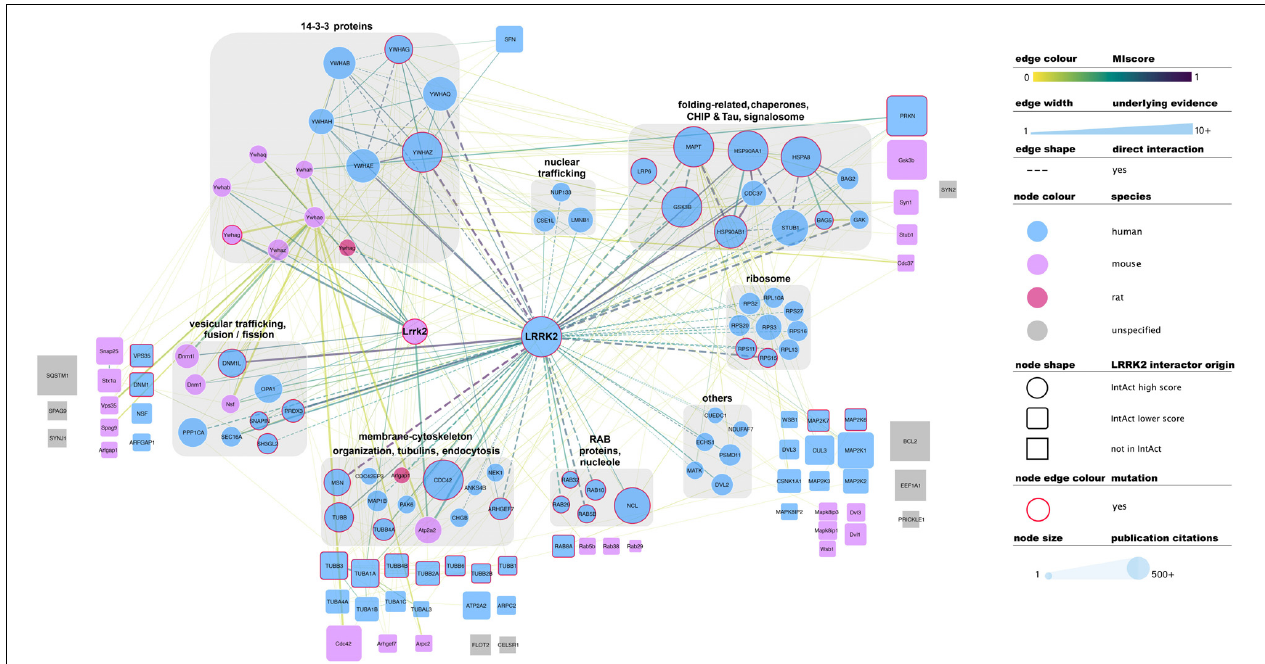
FIGURE 2 | Selected, bona fide LRRK2 interacting partners as found in the IntAct database. Top bona fide LRRK2 interactors have been grouped in different categories depending on the processes they play a role in, groups are highlighted with gray round boxes and titled accordingly. Known LRRK2 interactors that did not meet the MIscore ≥ 0.6 threshold are represented as rounded squares and those that are missing from Intact are represented as gray squares. Both have been located in the figure next to the broad categories defined for top bona fide LRRK2 interactors. Edges connecting lower confidence LRRK2 interactors to LRRK2/Lrrk2 have been omitted for the sake of clarity. Edges represented as dashed lines identify interactions for which there is experimental evidence for direct binding. For the rest of the visual features, please refer to in-figure legend and figure 1 legend. An interactive and downloadable version of this network can be found at